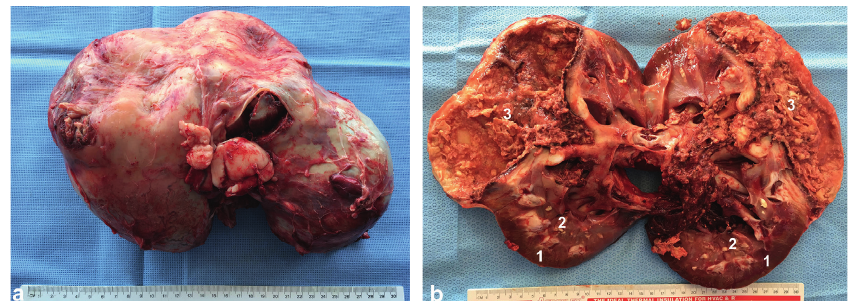
Figure 15: Gross pathological findings in a female dromedary camel with chronic suppurative pyelonephritis caused by Staphylococcus lugdunensis. Image (a) shows an enlarged abscessed kidney, while image (b) shows a longitudinal section of the affected kidney with corticomedullary abscess [31]. 1, cortex; 2, medulla; 3, abscess cavity.